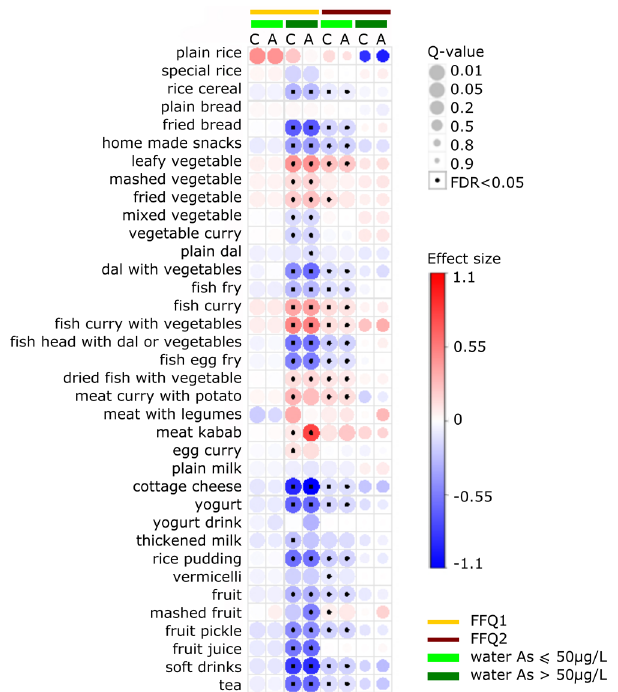
Figure 2. Associations between natural log ‐ transformed food intake (g/day) and natural log ‐ transformed toenail As concentration ( μ g/g) measured by the first and the second dietary assessment (FFQ1 and FFQ2, respectively) among women exposing to drinking water As concentration of >50 μ g/L and ≤ 50 μ g/L in Bangladesh. Effect size is the slope coefficients ( β(cid:3552) ) for each dietary item and has the unit of ln((toenail As concentrations, μ g/g) ∙ (g/day) − 1 ). “C” stands for crude model adjusted for water As concentration only; “A” stands for adjusted model adjusted for water As level, sex, smoking in the living environment, chewing betel nut, BMI, daily water intake, daily energy intake, and education level. Q ‐ value accounting for multiple comparisons using the false discovery rate (FDR = 0.05) method. (Quantitative values presented in the Supplementary Materials, Tables S1 and S2).